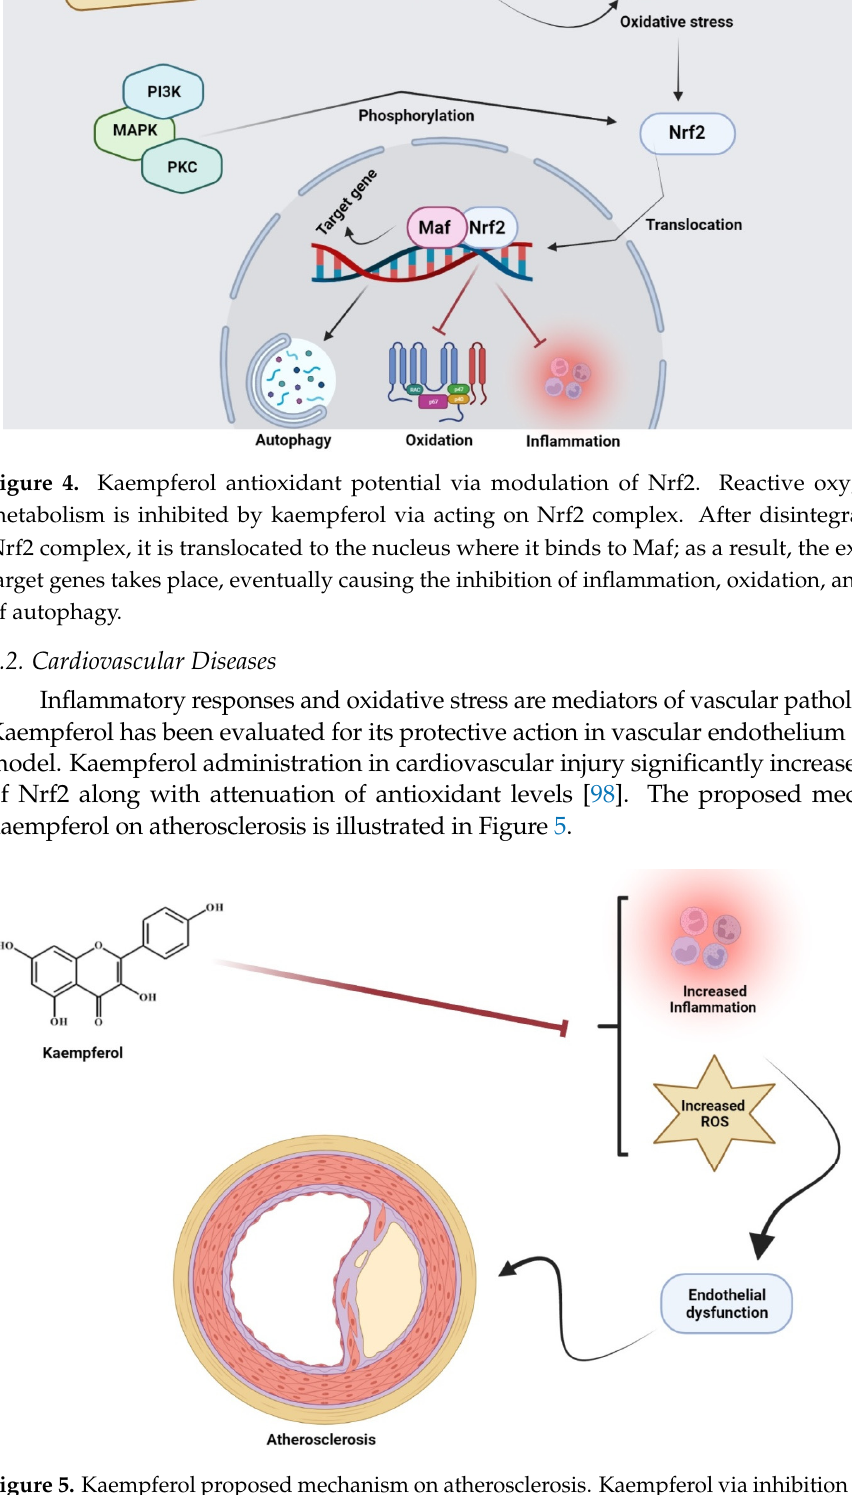
Figure 5. Kaempferol proposed mechanism on atherosclerosis. Kaempferol via inhibition of increased inflammation and reactive oxygen species through modulation of endothelial dysfunction that results in inhibition of atherosclerosis.